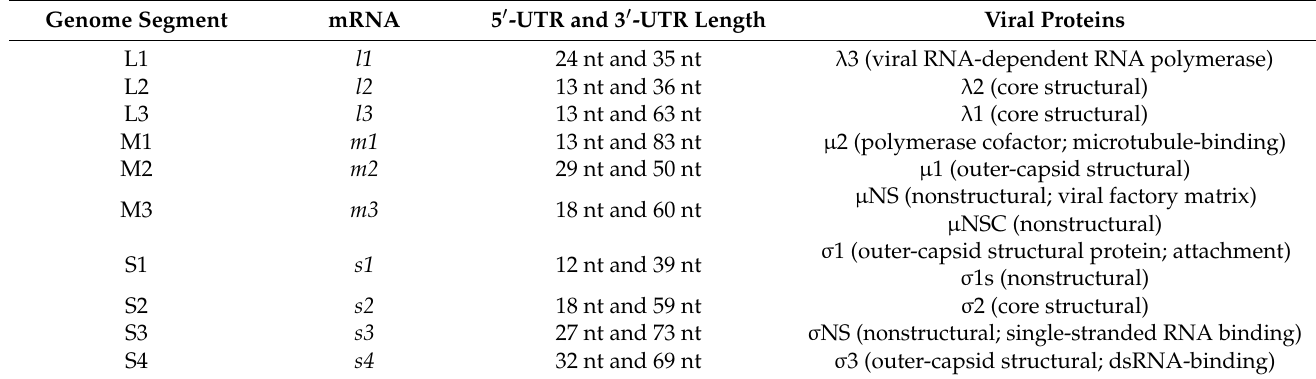
Table 1. Reovirus genome segments, mRNAs, and